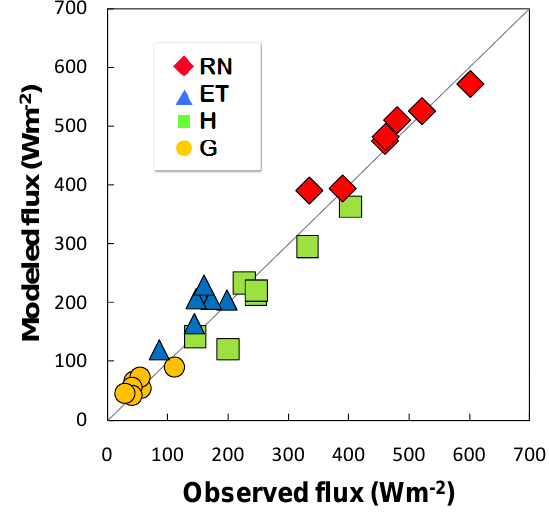
Fig. 10. Comparison between measured and modeled flux compo- nents obtained by applying the TSEB to aircraft imagery collected over an olive grove in Castelvetrano (Sicily) in an experiment de- scribed by Cammalleri et al. (2010). This plot summarizes data from Fig. 8 in Cammalleri et al, showing results obtained using the Goudriaan (1977) in-canopy wind profile scheme. Flux measure- ments represent an average of eddy correlation and coherent scintil- lometer data collected